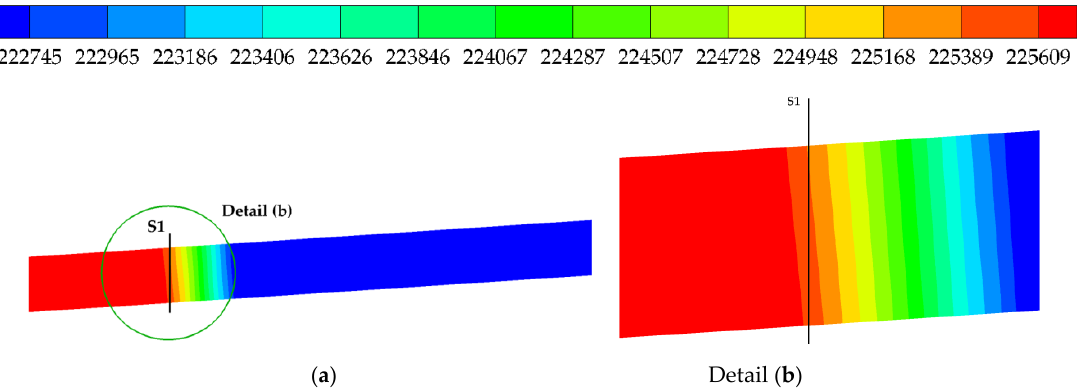
Figure 27. T = 0.0774 s Pressure field on the axis plane of the pipeline ( a ) and local pressure distribution around S1 monitoring position ( b ).